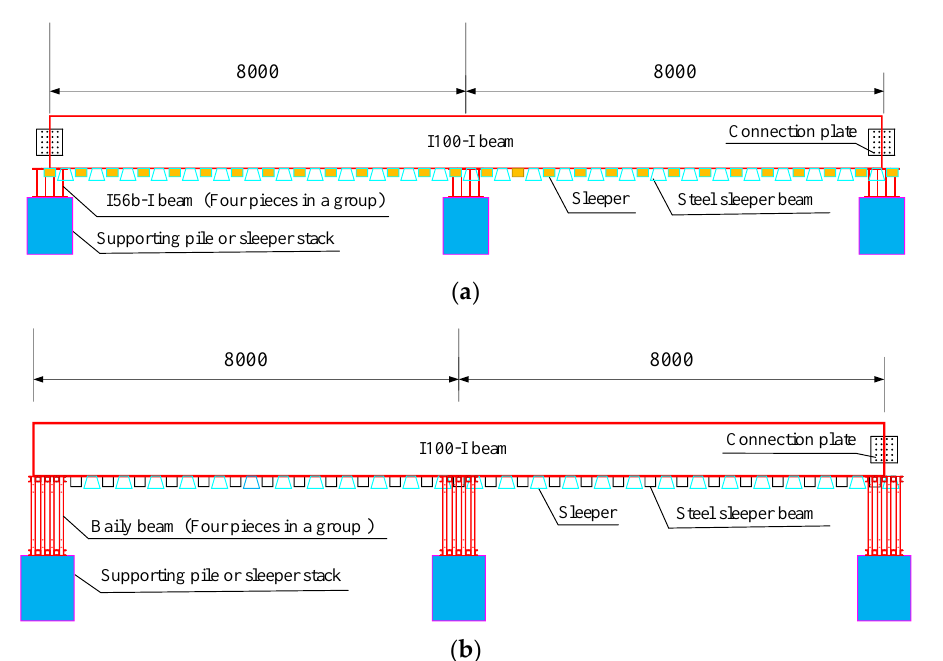
Figure 2. Elevation of the overhead system (unit: mm): ( a ) Elevation of type I overhand system. ( b ) Elevation of type II overhand system.